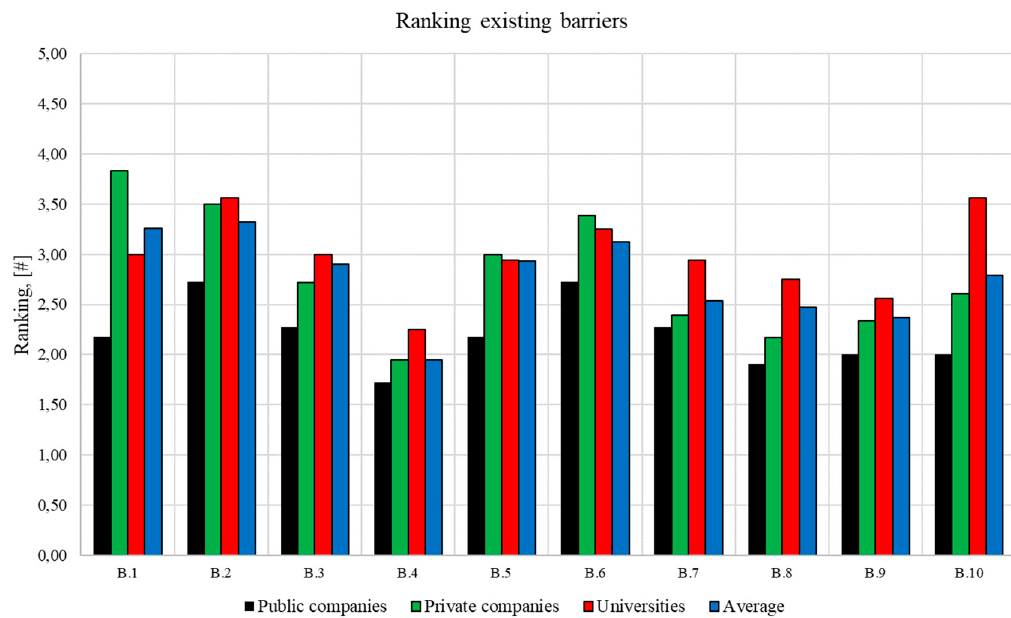
Figure 30. Ranking of the identified existing barriers as a function of the organization type.